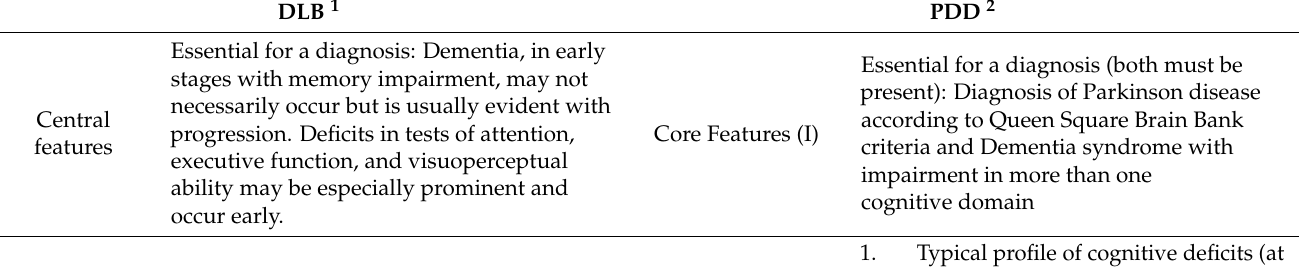
Table 1. Criteria for the clinical diagnosis of probable and possible dementia with Lewy bodies (DLB) and Parkinson’s disease dementia